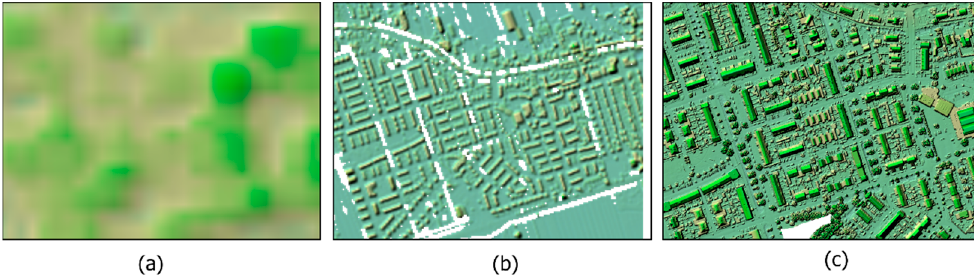
Figure 2. Example of varying spatial resolution of the digital elevation models; ( a ) 30 m ( b ) 5 m and ( c ) 50 cm. The white areas correspond to missing data.